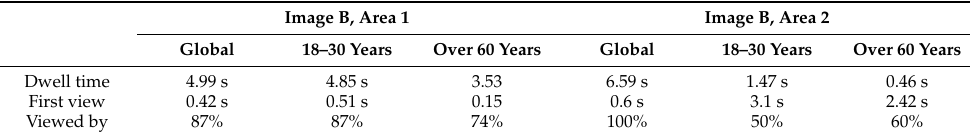
Table 6. Age segments analysis. Image